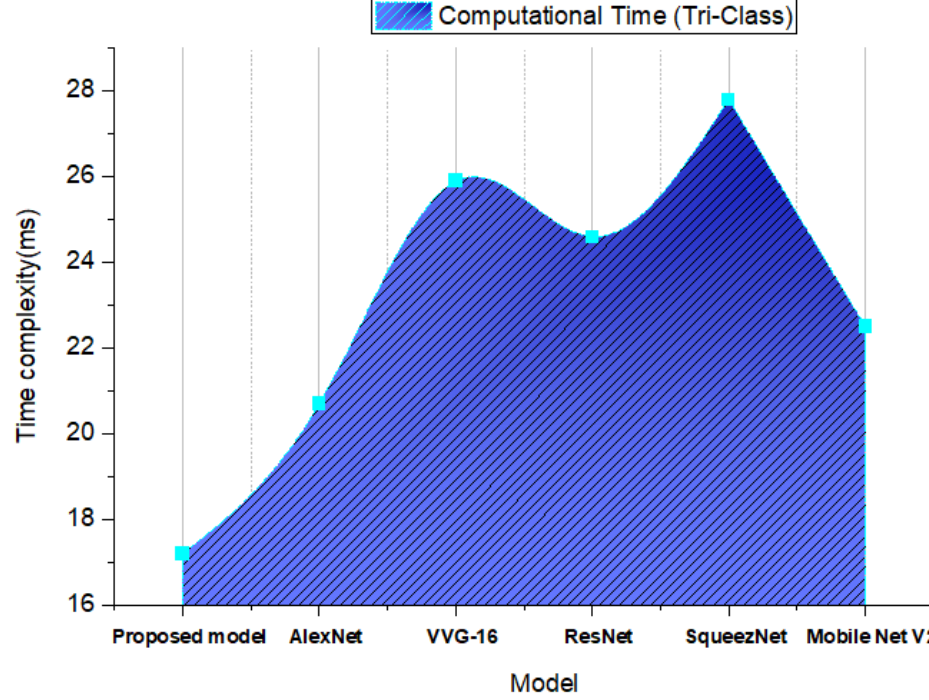
Figure 11. The time complexity of the proposed transfer learning techniques in brain tumor detec- tion.